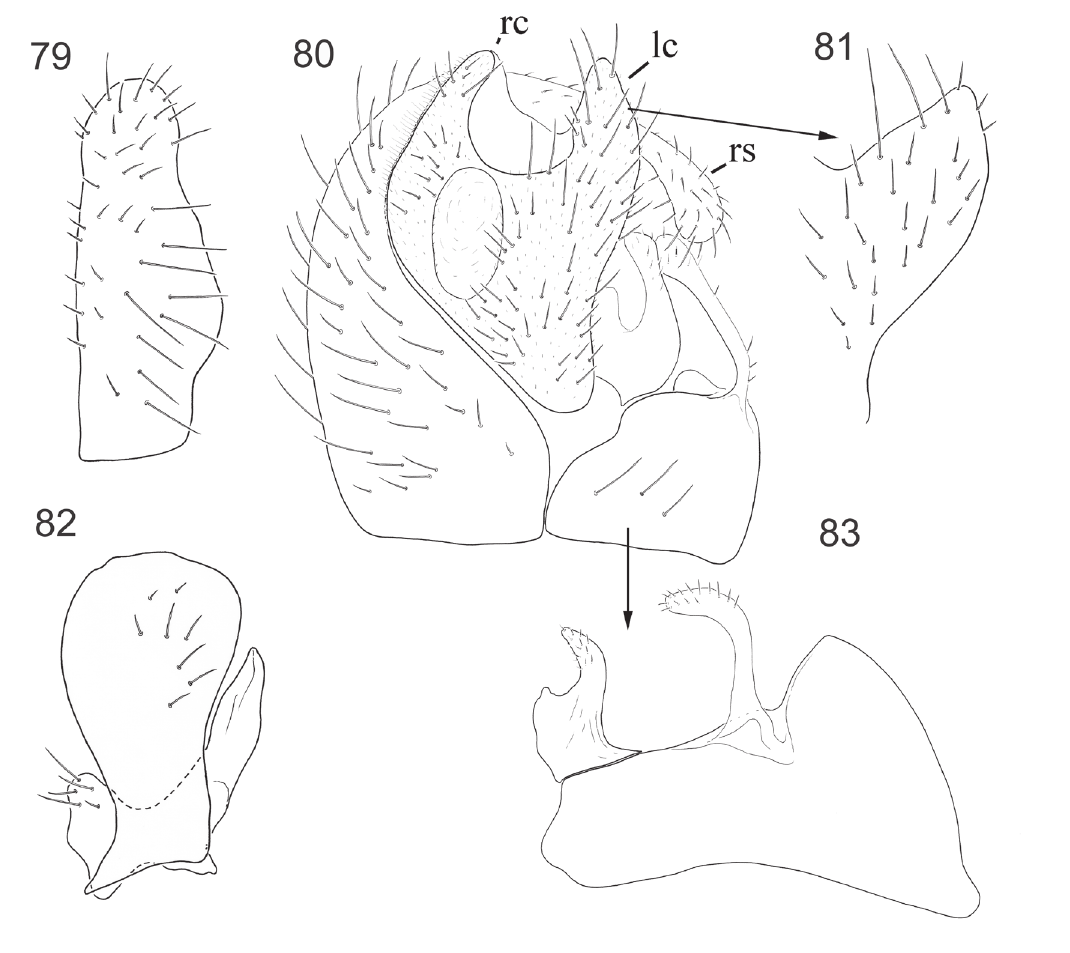
Figs 79-83. Crossopalpus hirsutipes Collin, 1960, ♂ terminalia. 79 . right surstylus dorsal view. 80 . epandrium and cerci, dorsal view. 81 . tip of left cercus, lateral view. 82 . lower lobe of right surstylus. 83 . left epandrial lamella, lateral view (after Shamshev et al.